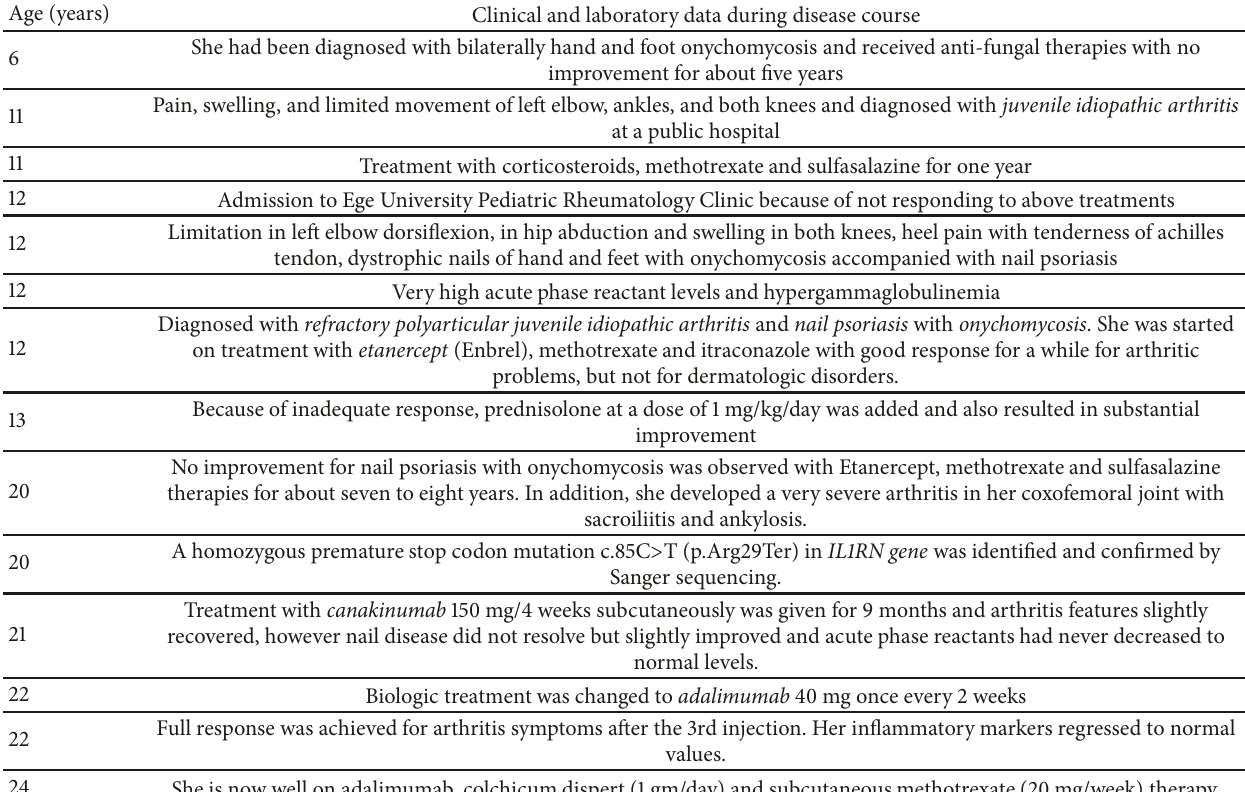
Table 1: A summary of the clinical and laboratory features during the disease